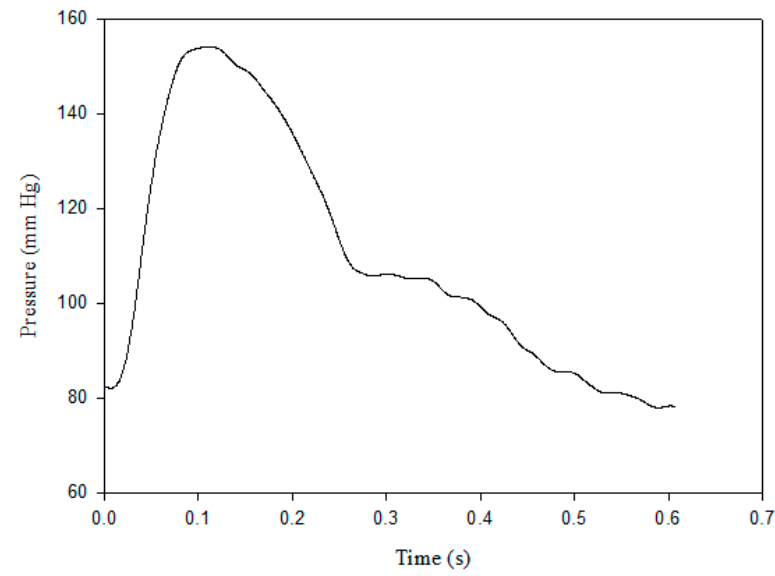
Figure 2. The definitions of pressure and time symbols on the blood pressure contour.